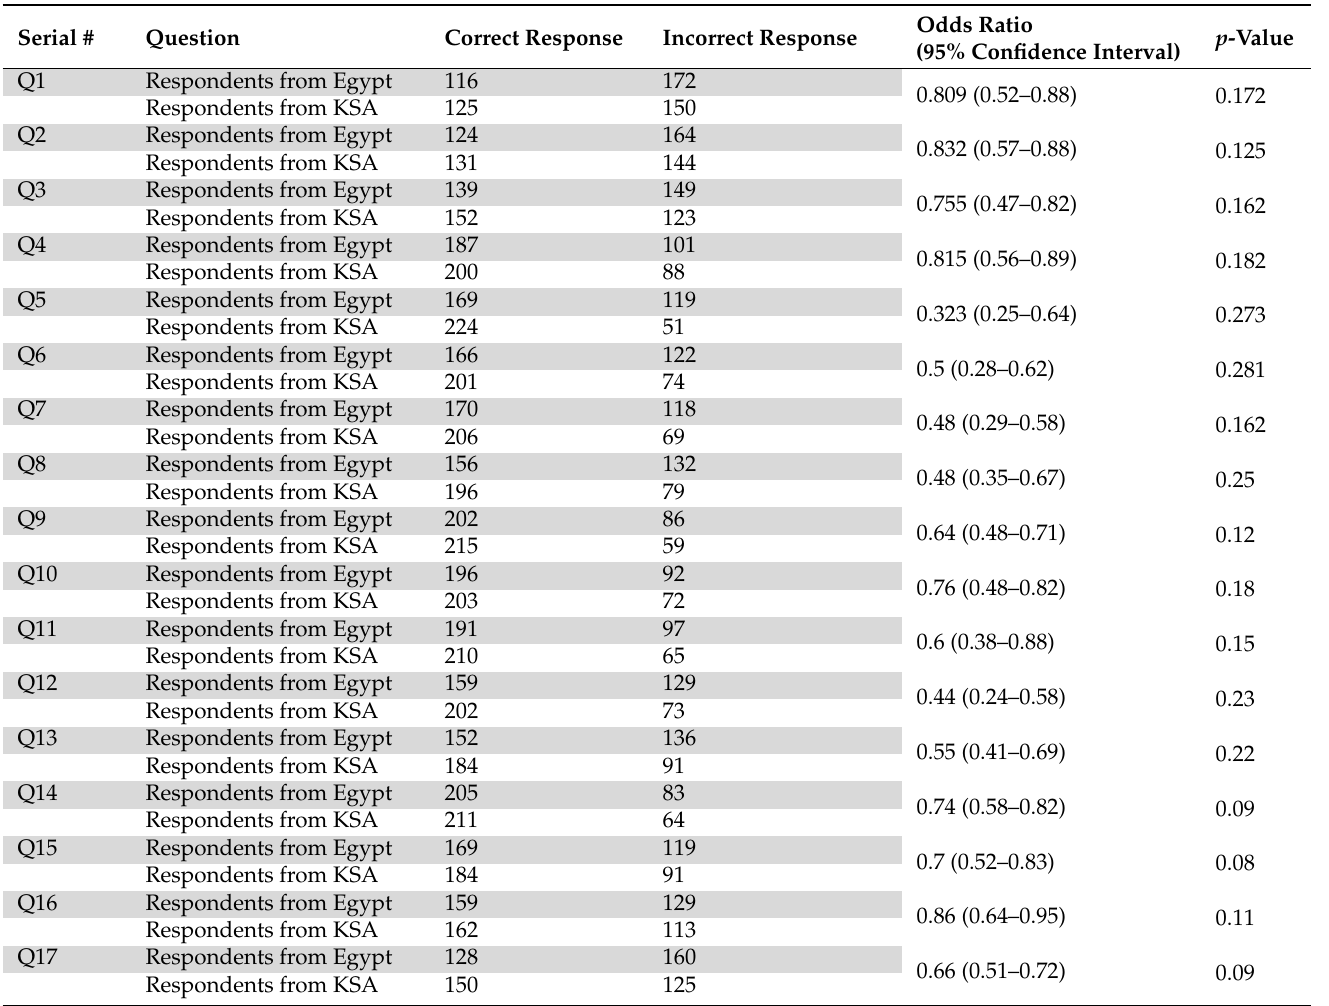
Figure 1. The percentages of correct responses for the 17 questions submitted by respondents from Egypt (red) and the Kingdom of Saudi Arabia (blue). Table 3. Odds ratios and 95% confidence intervals for correct and incorrect responses to the